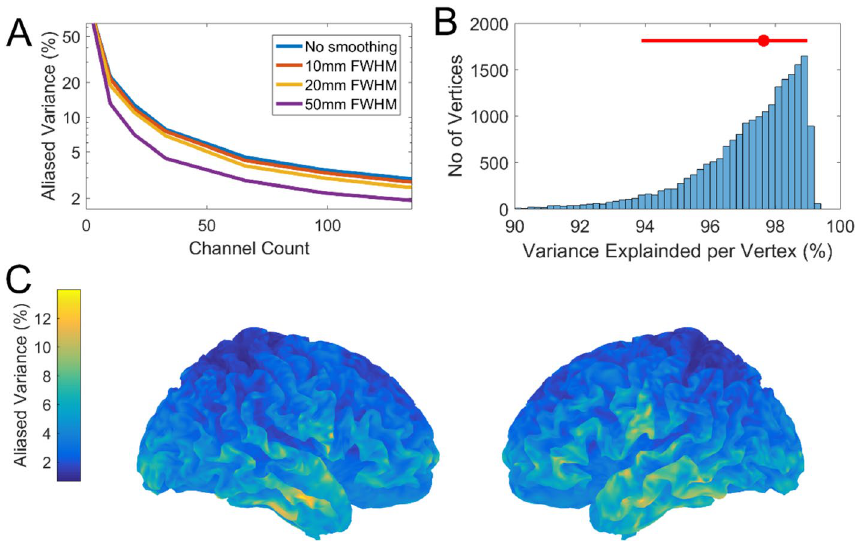
Figure 7. The effects of aliasing. In ( A ) the percentage of aliased variance (from the lead field covariance matrix) is plotted as function of channel count. The Y axis is logarithmically scaled. This is repeated for different levels of source space smoothness (no smoothing, 10 mm, 20 mm and 50 mm). In ( B ) the histogram of variance explained across the entire cortex is calculated for an array of 100 sensors. The median variance explained (red dot) is highlighted as well as the 2.5% and 97.5% quantiles (red bar). In ( C ) this same information is visualised across the cortical surface to characterise the spatial profile of